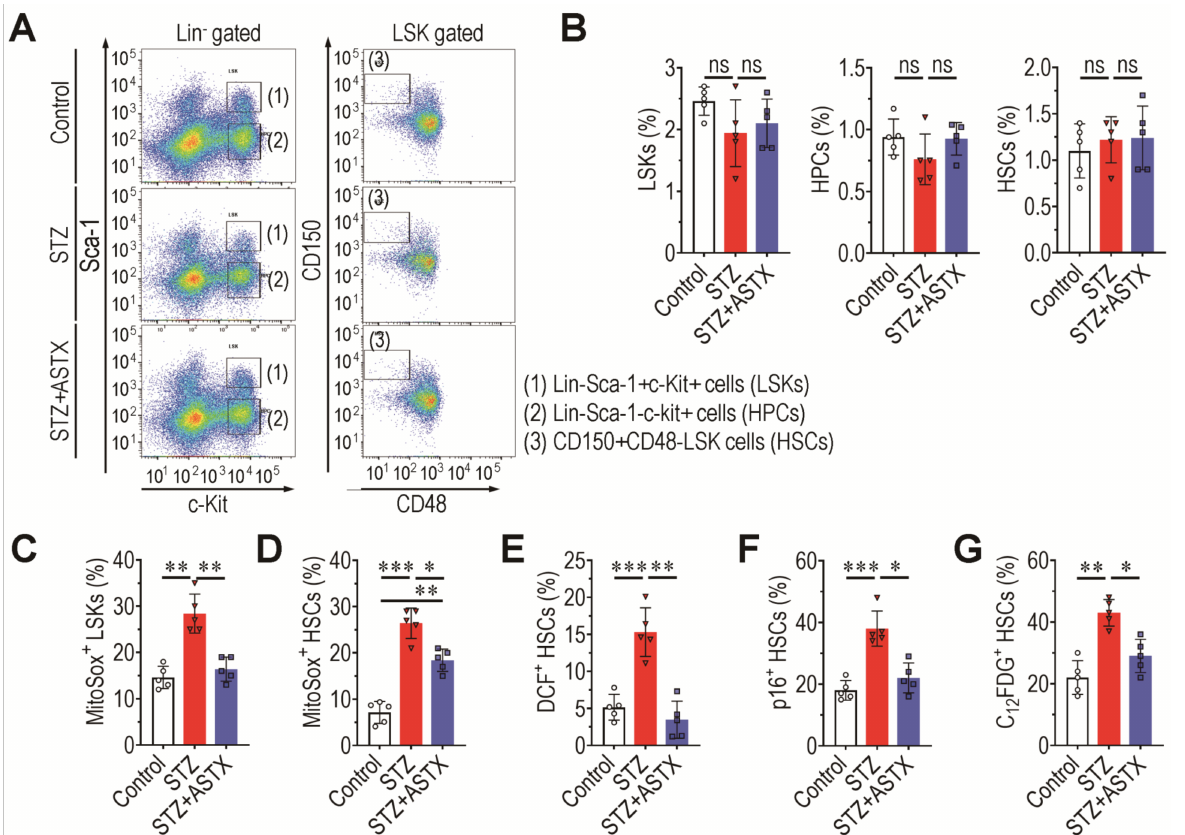
Figure 5. Supplemental ASTX attenuates hyperglycemia-induced oxidative stress and senescence in BM HSCs of STZ-injected mice. ( A ) BM frequencies of LSK cells, HPCs, and HSCs were analyzed by flow cytometry using specific markers. Representative results from five experiments are shown. ( B ) Mean percentages of these hematopoietic cells were calculated ( n = 5/group). Levels of mitochon- drial superoxide anions in ( C ) BM LSK cells and ( D ) HSCs, along with ( E ) BM levels of DCF + HSCs in the mouse groups, were assessed by flow cytometry using MitoSox TM Red or DCF-DA reagent at 60 days after hyperglycemia induction ( n = 5/group). ( F , G ) Levels of senescent HSCs in the BM of the mouse groups were also measured by flow cytometry using p16 INK4a and C 12 FDG on the same post-hyperglycemia day ( n = 5/group). * p < 0.05, ** p < 0.01, and *** p < 0.001 by unpaired Student’s t -test. ns, not